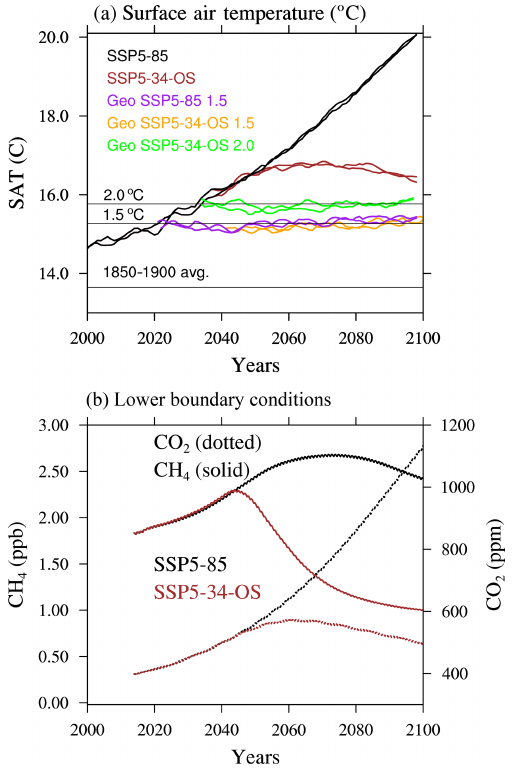
Figure 1. (a) Annual surface air temperature evolution for two en- semble members of the business-as-usual case (SSP5-85), the over- shoot case that is following the SSP-85 case until 2040 and then starting strong mitigation and carbon dioxide removal (SSP5-34- OS), and for three different SAG scenarios: based on the SSP5-85 baseline scenario and applying sulfur injections to reduce warming to 1.5 ◦ C above pre-industrial (PI) conditions (Geo SSP5-85 1.5); based on the SSP5-34-OS and reducing warming to 1.5 ◦ C above PI (Geo SSP5-34-OS 1.5), and based on the SSP5-34-OS and reducing warming to 2.0 ◦ C above PI (Geo SSP5-34-OS 2.0) A 10-year run- ning mean has been applied to all the time series. Black lines indi- cate the 1850–1900 temperature average (pre-industrial (PI) control temperatures) and the 1.5 and 2.0 ◦ C surface air temperatures above PI control. (b) Concentrations of carbon dioxide (CO 2 , dotted lines) and methane (CH 4 , solid line) for the two baseline